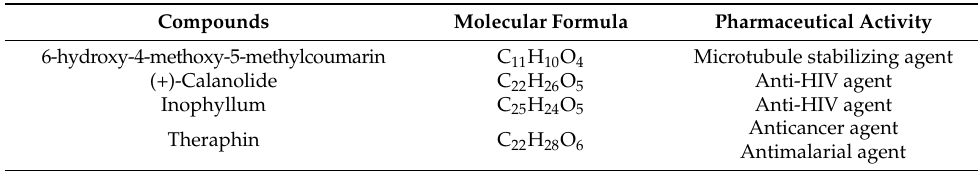
Table 6. Coumarin-based compounds obtained from the medicinal plants used by various ancient medical systems